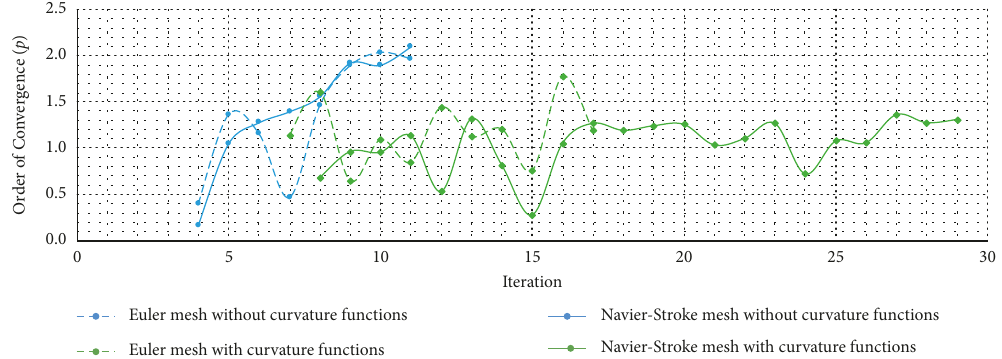
Figure 21: Order of convergence for the Euler and Navier–Stokes meshes, with and without curvature